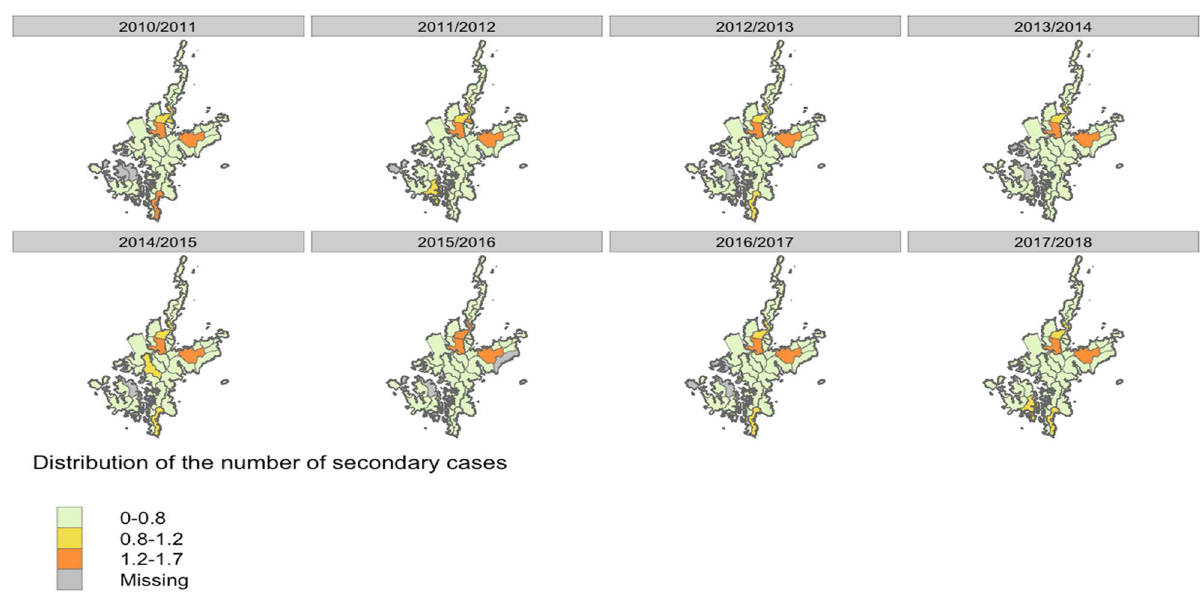
Figure 5. Median number of secondary cases per each influenza case, stratified by district and by season